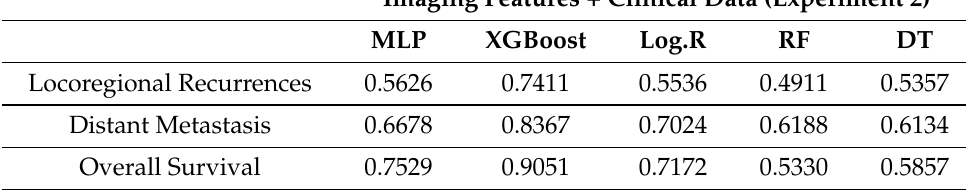
Table 3. Global results (AUC values) of LR, DM, and OS predictions for the imaging features + clinical data (Experiment 2)